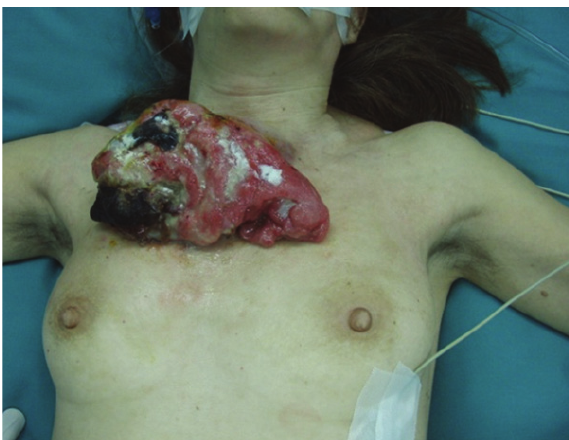
Figure 1: Solitary fibrous tumour of the anterior thoracic wall.